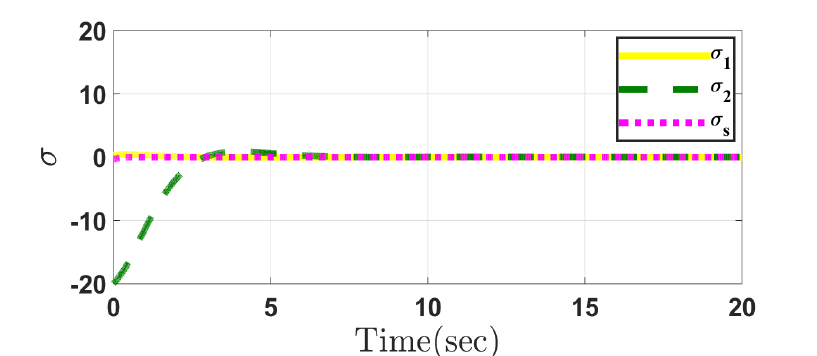
Figure 5. Sliding mode surfaces in the conventional method in Case 1.